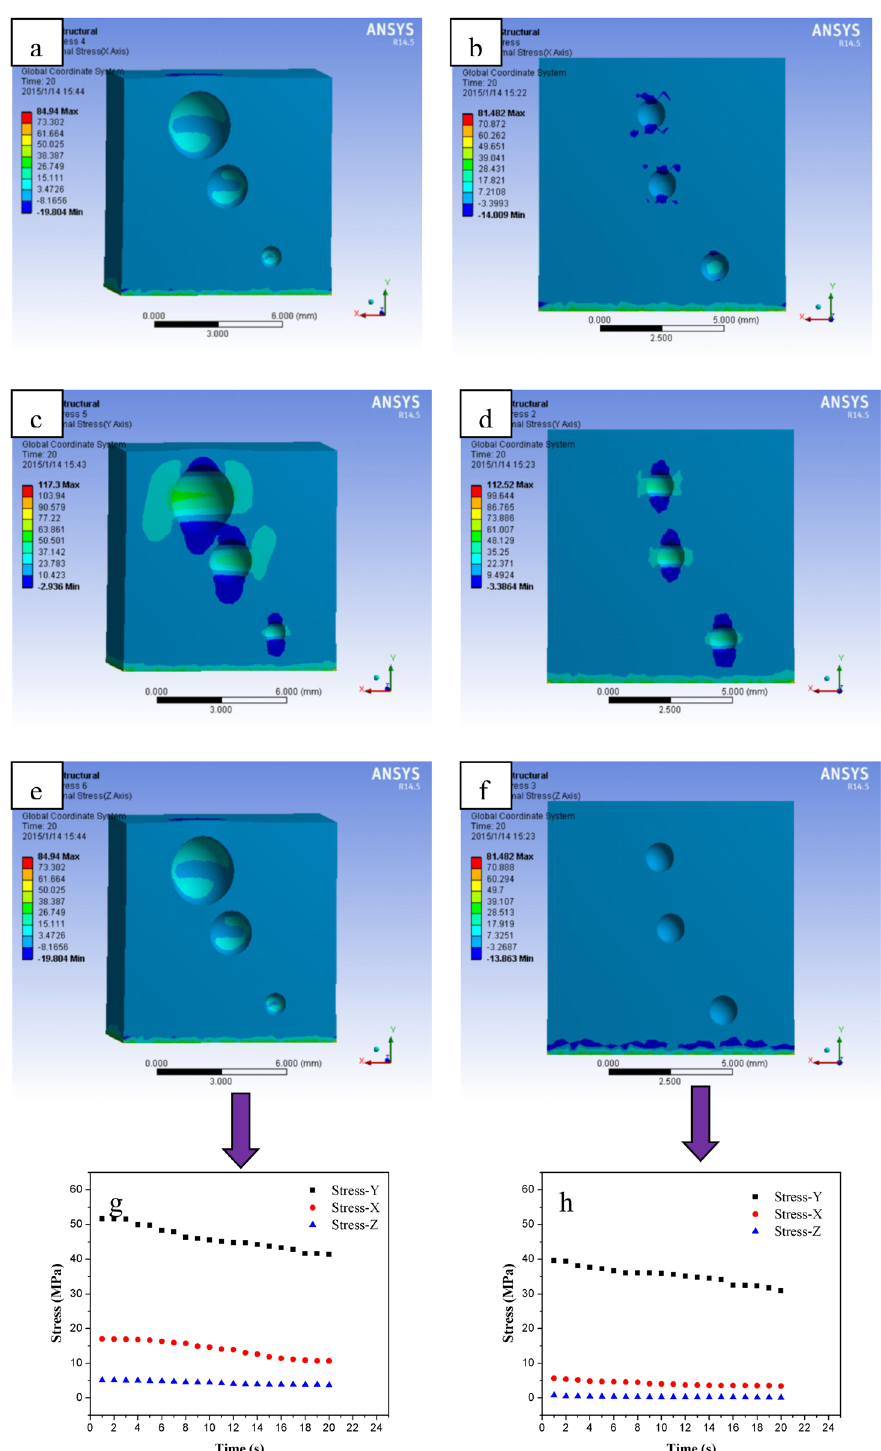
Figure 10: Three - dimensional stress analysis of foamed samples with wide ( a, c, e and g ) and narrow ( b, d, f and h ) cell size distributions: ( a and b ) along x direction, ( c and d ) along y direction, ( e and f ) along y direction, ( g and h ) along the x , y , and z